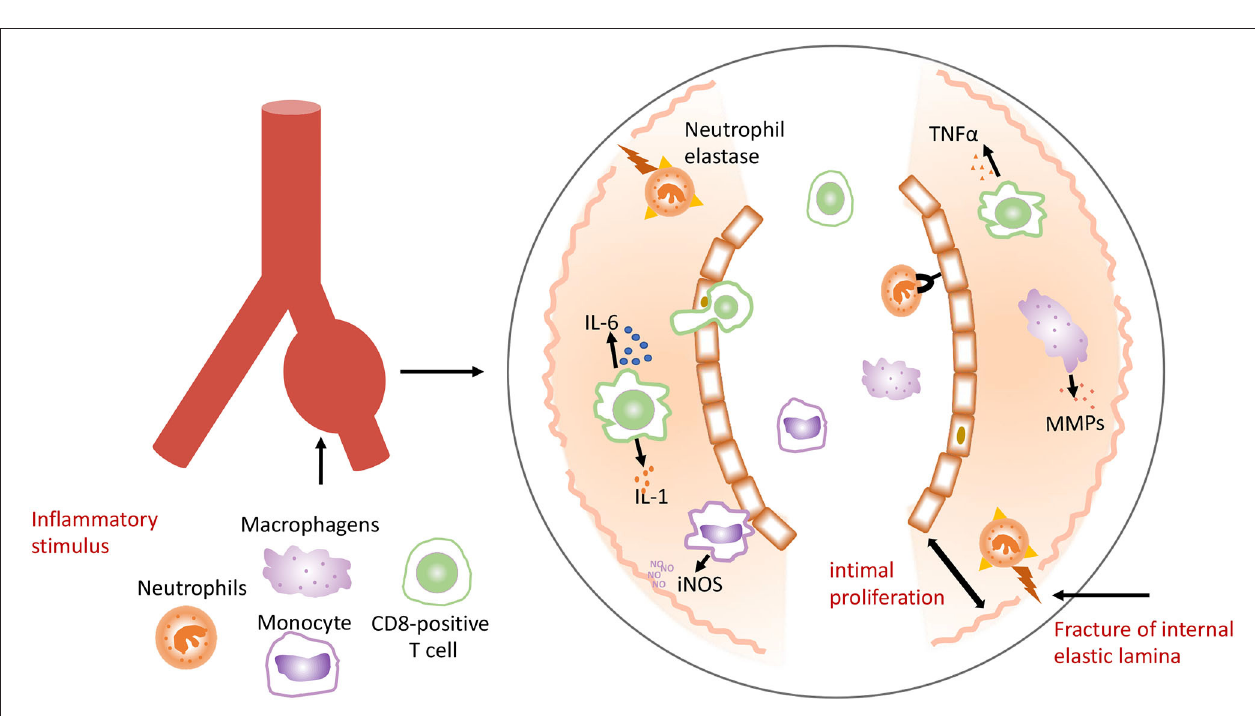
FIGURE 2 | Inflammatory stimulus in Kawasaki